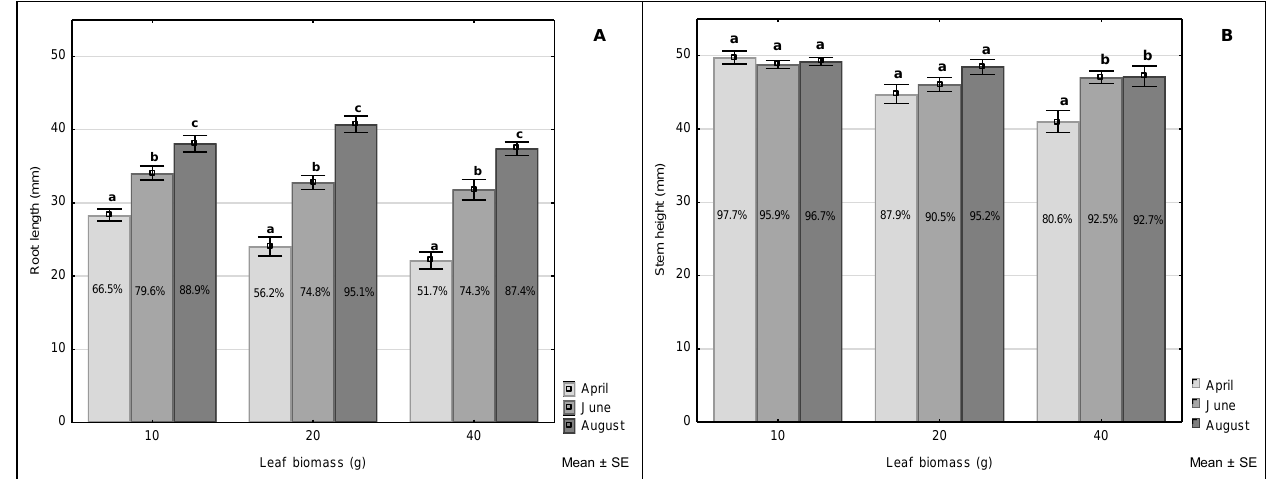
Figure 1. Effects of volatiles released by Prunus serotina leaves, collected in three months of the growing season (April, June and August), on root length ( A ) and stem height ( B ) of Pinus sylvestris seedlings. Data are mean ± SE. Numbers in bars represent % of control. Significant differences between collected dates for each leaf biomass (marked with letters a, b, c) were estimated by the Tukey HSD test at p ≤ 0.05; n = 15.